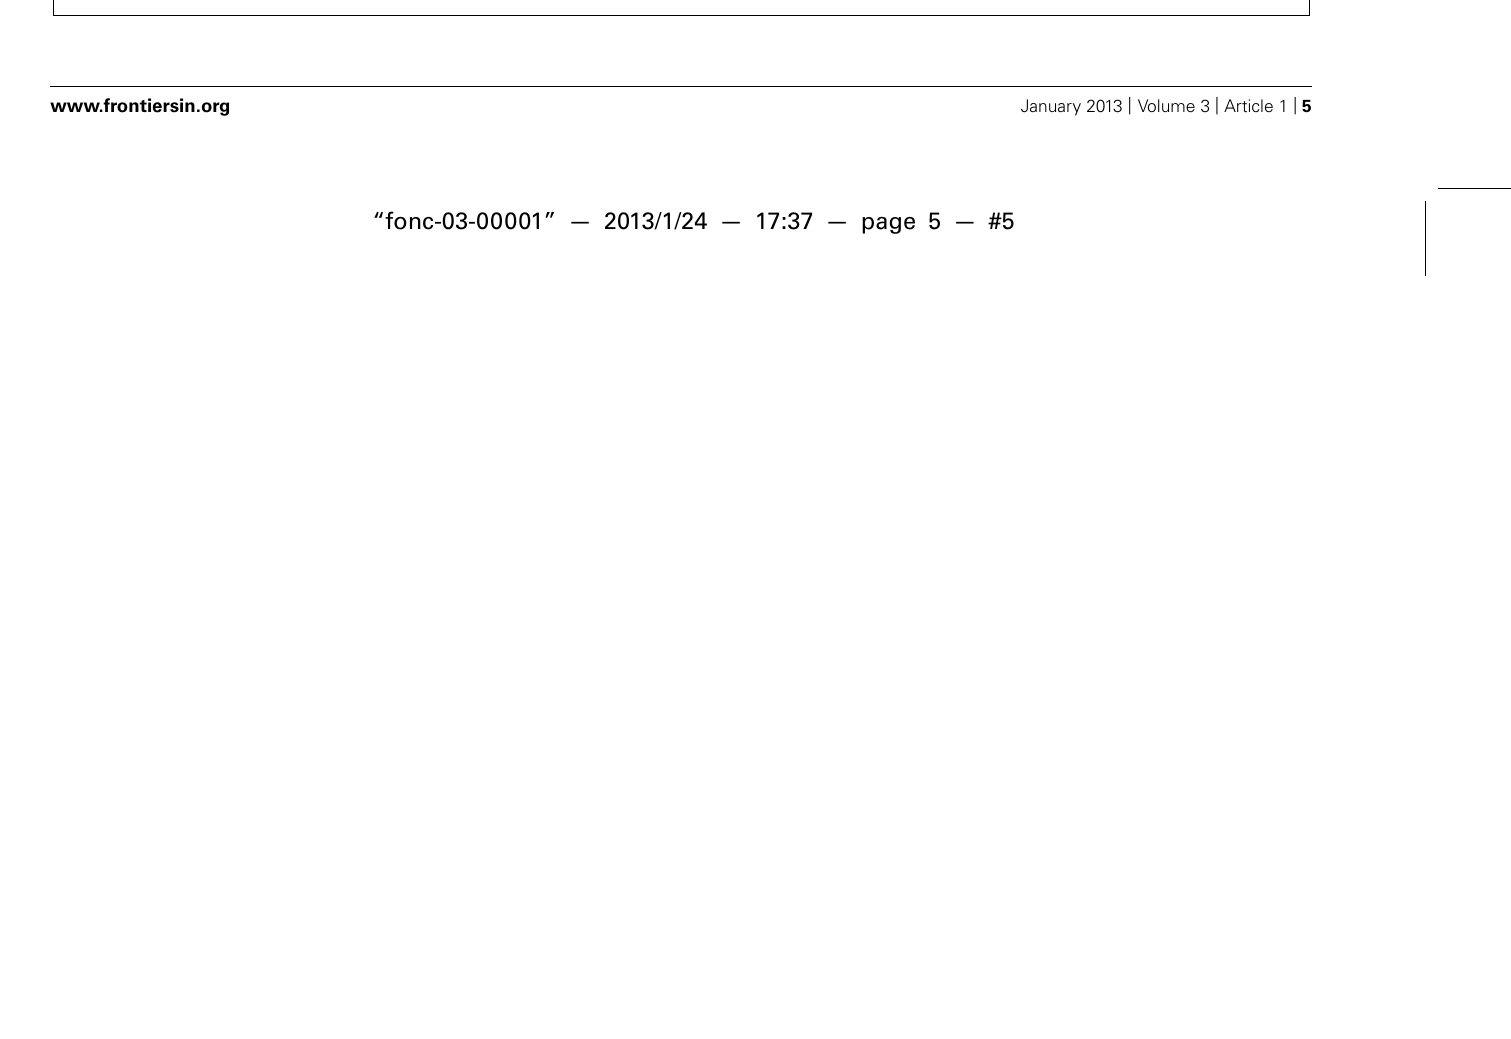
FIGURE 3 | MYCN influences global chromatin structure. (A) The SK-N-AS cell line contains a single copy of MYCN and does not express significant quantities. Upon transfection of SK-N-AS with MYCN (14-2,Vector control: